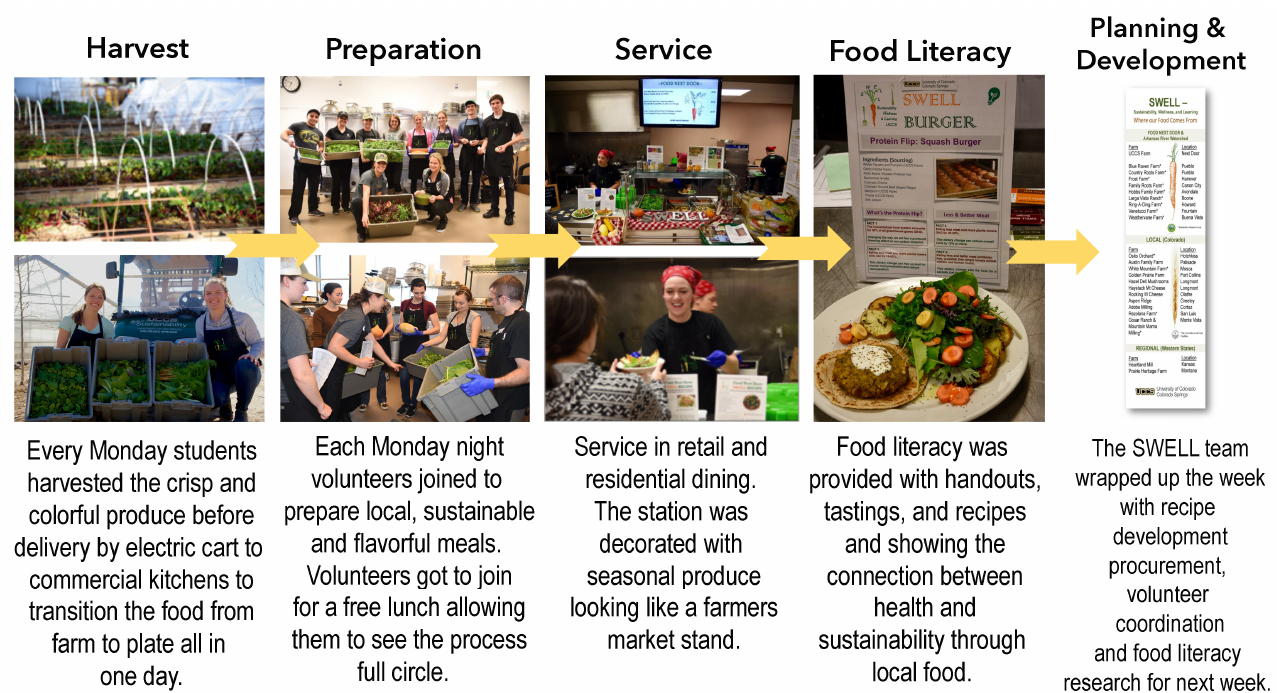
Figure 2. Weekly cyclic process managed by two Sustainability, Wellness & Learning (SWELL) graduate assistants (hired by Dining and Hospitality Services) who are in the Department of Human Physiology and Nutrition and specifically, in the Sport Nutrition Graduate Program.